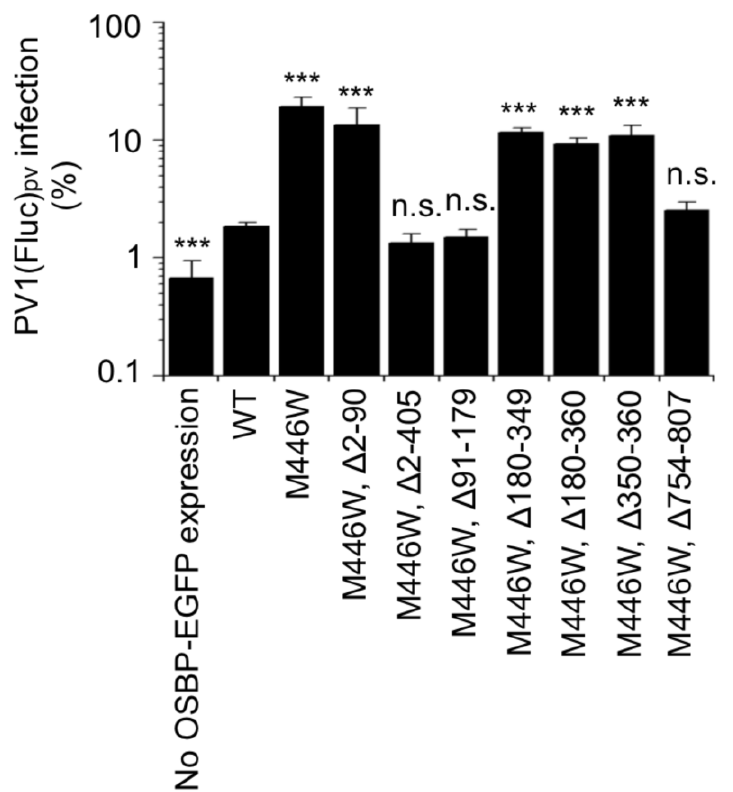
Figure 3. Functional dominance assay of OSBP. HEK293 cells expressing each of the OSBP variants were infected with PV1(Fluc) pv at an MOI of 0.5 at 37 ◦ C for 7 h in the presence (20 µ M) or absence of T-00127-HEV2. PV1(Fluc) pv infection in the absence of T-00127-HEV2 is taken as 100%. Statistical significance of the infection to that in the WT-expressing cells was shown. n.s., not significant. ***, p < 0.001. The data represent the mean and standard deviation of two independent experiments with two or three biological replicates.